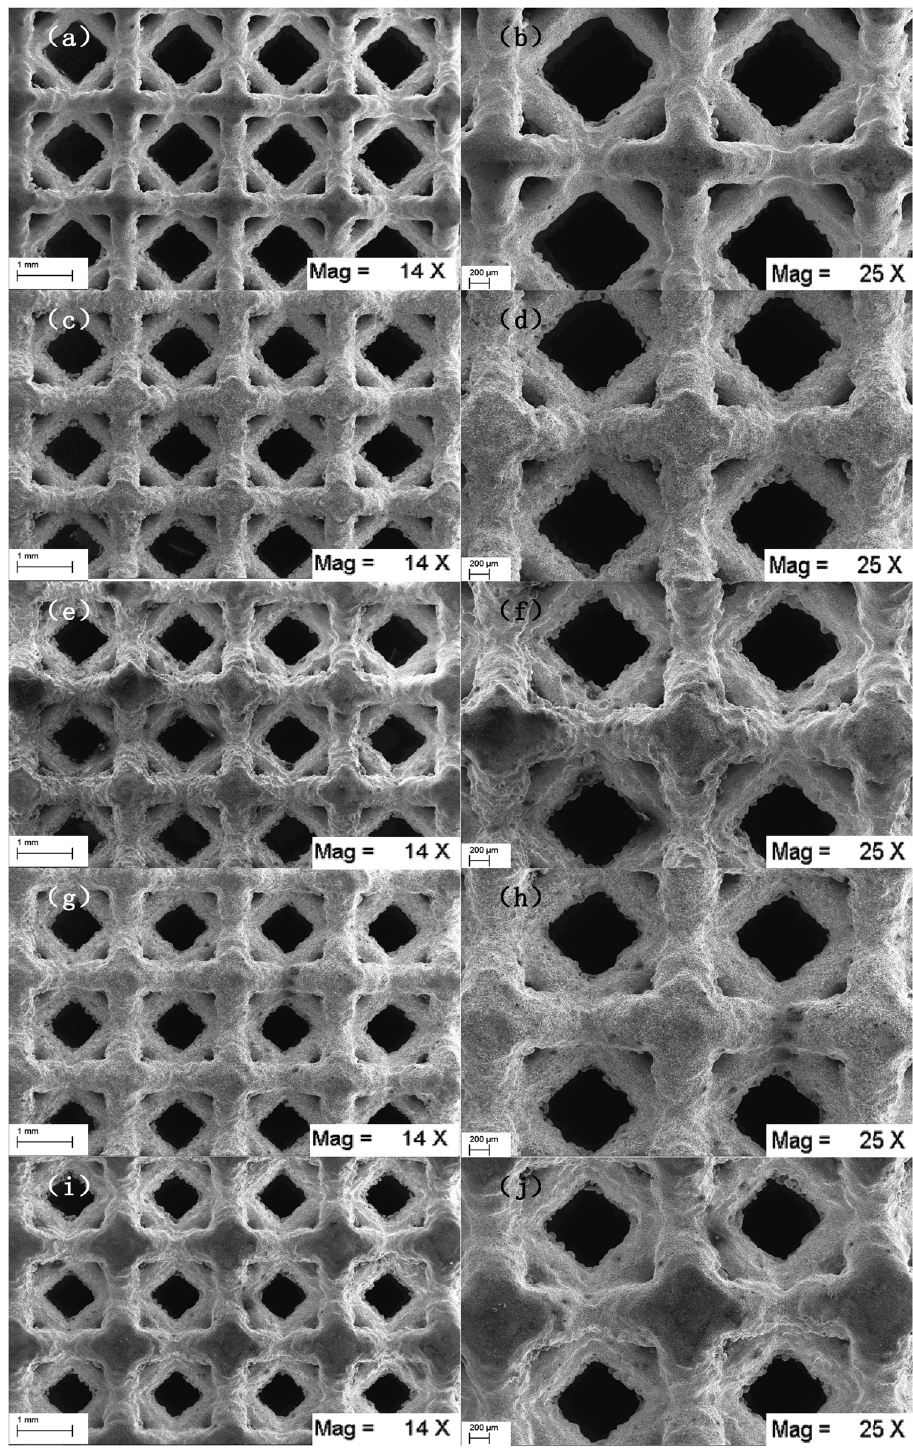
Figure 11: SEM surface topography of di ff erent sizes of 2 mm cells at 14 × and 25 × magni fi cation. ( a and b ) 0.6 mm edge diameter; ( c and d ) 0.65 mm edge diameter; ( e and f ) 0.7 mm diameter; ( g and h ) 0.75 mm edge diameter; and ( i and j ) 0.8 mm edge